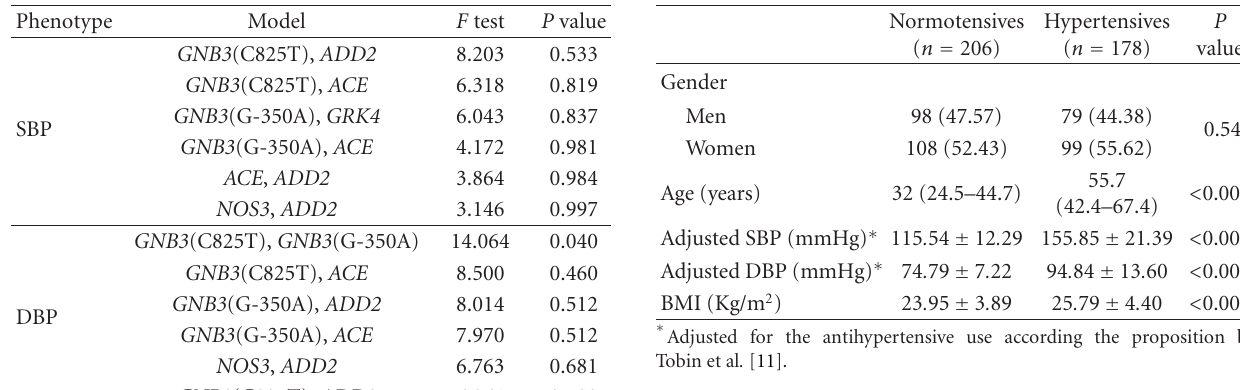
Table 3: Best two-locus models from FAM-MDR analyses. Table 4: Clinical characteristics of the unrelated quilombo